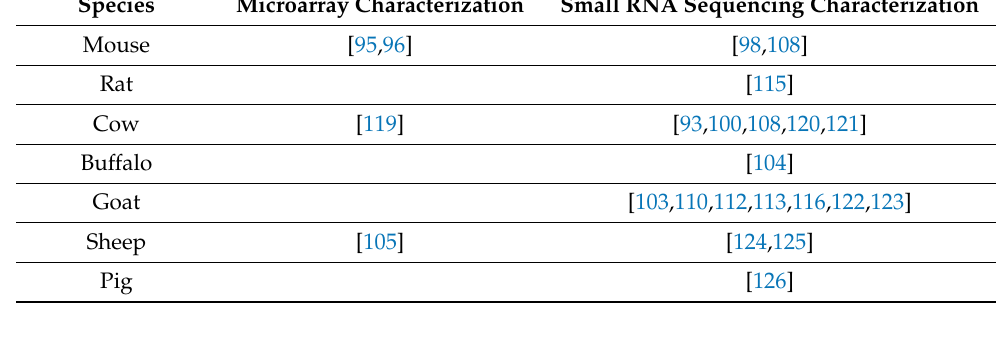
Table 2. Lactating mammary gland miRNomes.